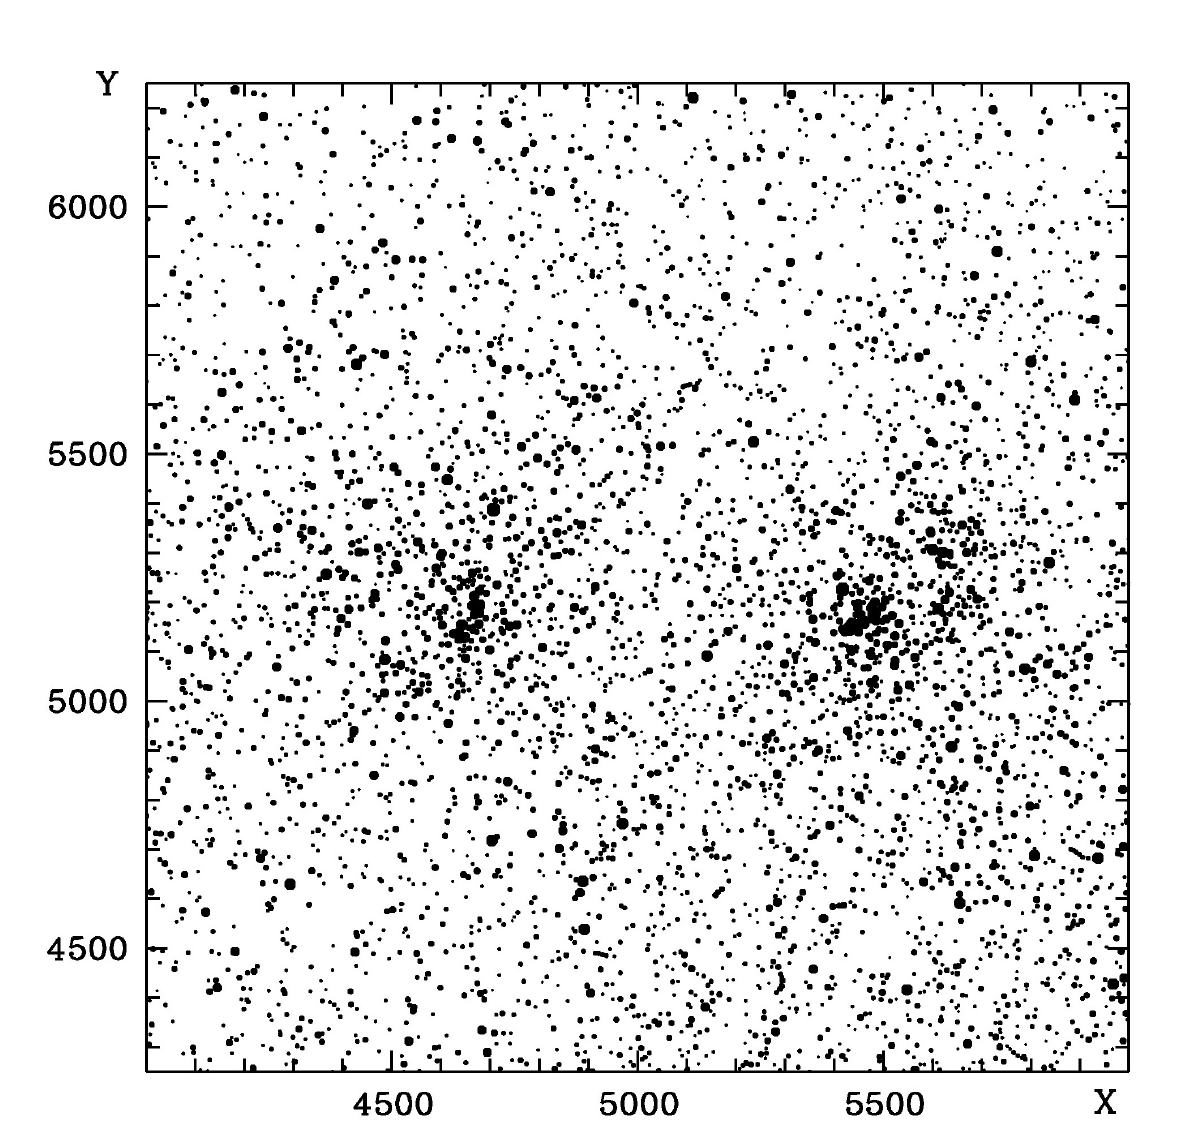
Figure 6. The map of the star sky in the area of the cluster χ and h Perseus for the plate Nr.6978 processing results.